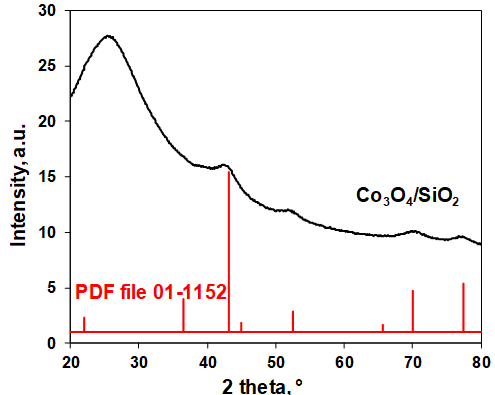
Figure 1. X-Ray Di ff raction analysis of non reduced Co / SiO 2 catalyst (vertical bars, Co 3 O 4 reference PDF file